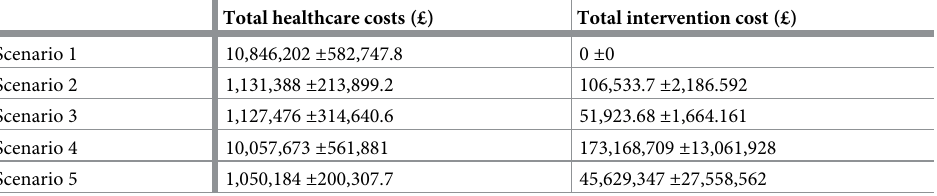
Table 4. Mean ( ± sd) model outputs for economic related endpoints over the lifetime of the simulated